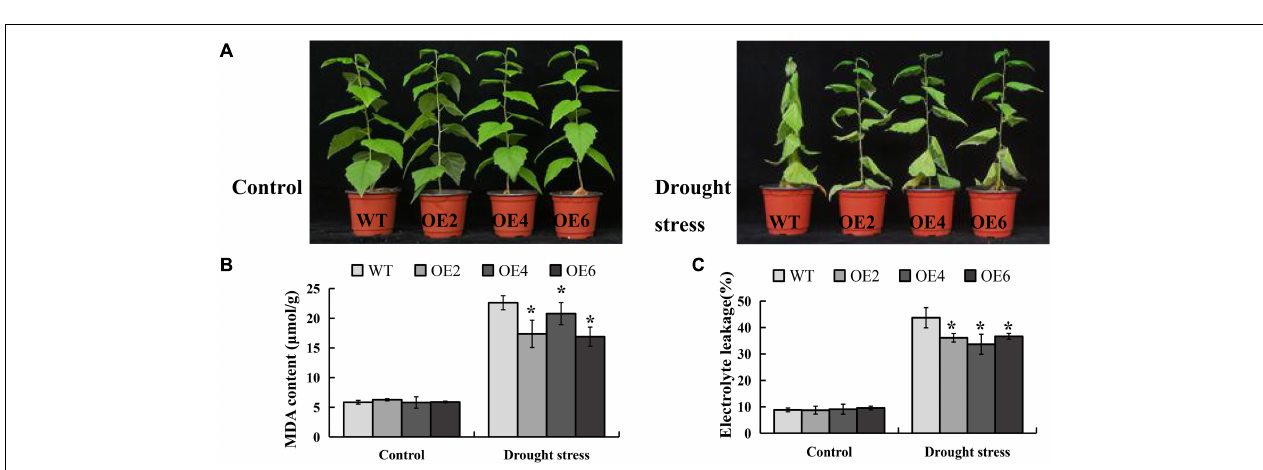
FIGURE 4 | BpLEA14 was the target gene of BpMYB123 . (A) Proximal locations of BpMYB123 binding cis -elements in BpLEA14 promoter sequence. (B) BpMYB123 could bind to the promoter of BpLEA14 . (C) Chromosomal immunoprecipitation (ChIP)-PCR analysis proved the binding of BpMYB123 to BpLEA14 promoter in vivo using an anti-GFP tag antibody for ChIP.